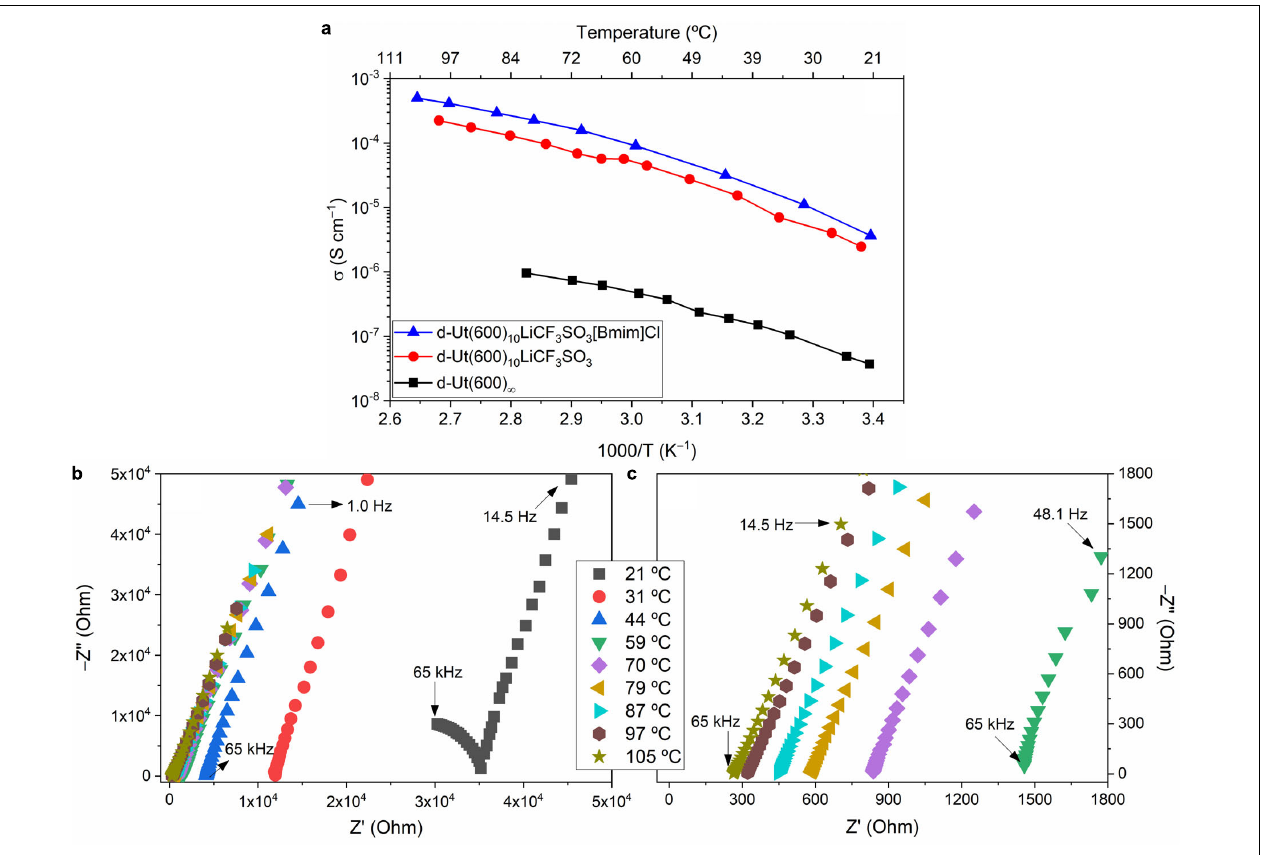
FIGURE 4 | Ionic conductivity of d-Ut(600) ∞ (black line) (Gonçalves et al., 2010), d-Ut(600) 10 LiCF 3 SO 3 (red line) (Gonçalves et al., 2010), and d-Ut(600) 10 LiCF 3 SO 3 [Bmim]Cl (blue line) (a) . The lines drawn are just a guide for the eyes. Nyquist plot (b) and zoom the 0–1800 Ohm interval (c) for d-Ut(600) 10 LiCF 3 SO 3